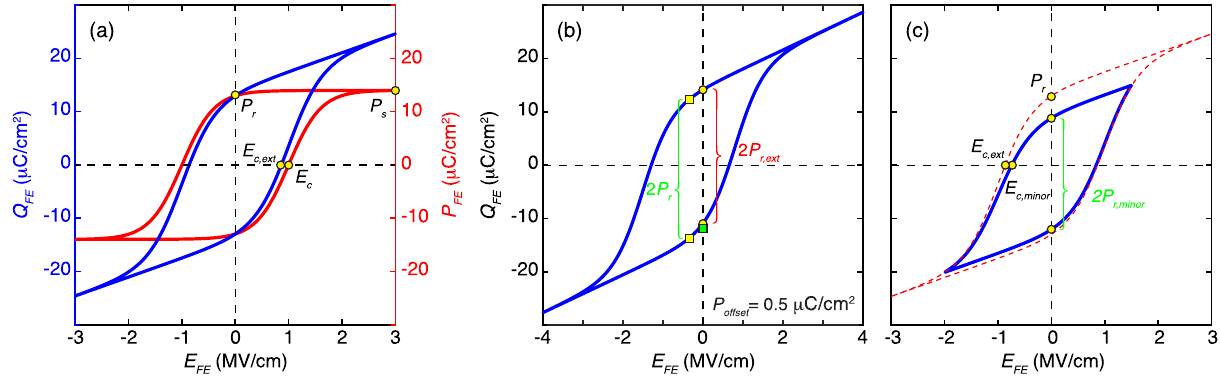
Figure 1. Issues with direct determination of ferroelectric parameters. ( a ) A typical ferroelectric hysteresis loop ( Q FE - E FE ), where E c , ext directly determined at Q FE = 0 μC/cm 2 is smaller than the actually E c from the P FE - E FE loops. In addition, P s is not obvious from the Q FE - E FE curve. ( b ) A hysteresis loop with asymmetrical E c ± and non-zero P offset , where 2 P r , ext is smaller than 2 P r , leading to underestimation. The green square indicates the endpoint of the 2 P r when the start point (top yellow square) of the 2 P r aligned with that (top yellow circle) of the 2 P r , ext . ( c ) A minor hysteresis loop (blue) and the corresponding saturated hysteresis loop (dashed red), where 2 P r , minor is smaller than 2 P r and E c , minor is less than E c , ext . Extracting ferroelectric parameters from a minor loop leads to